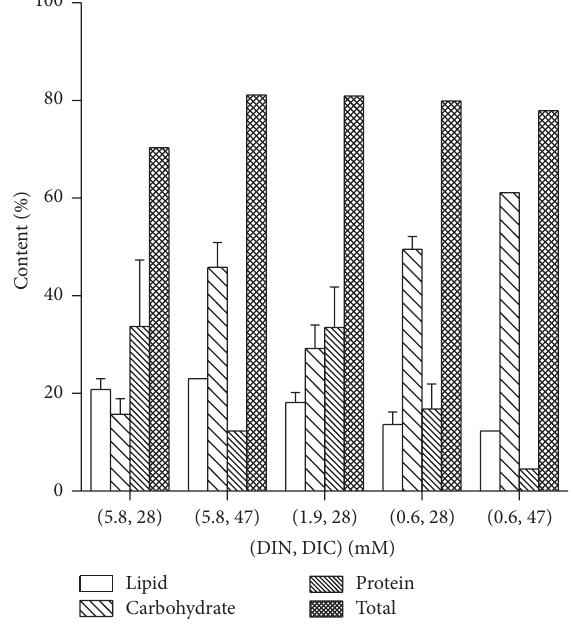
Figure 5: Cellular composition under various DIC and DIN concentrations in a batch